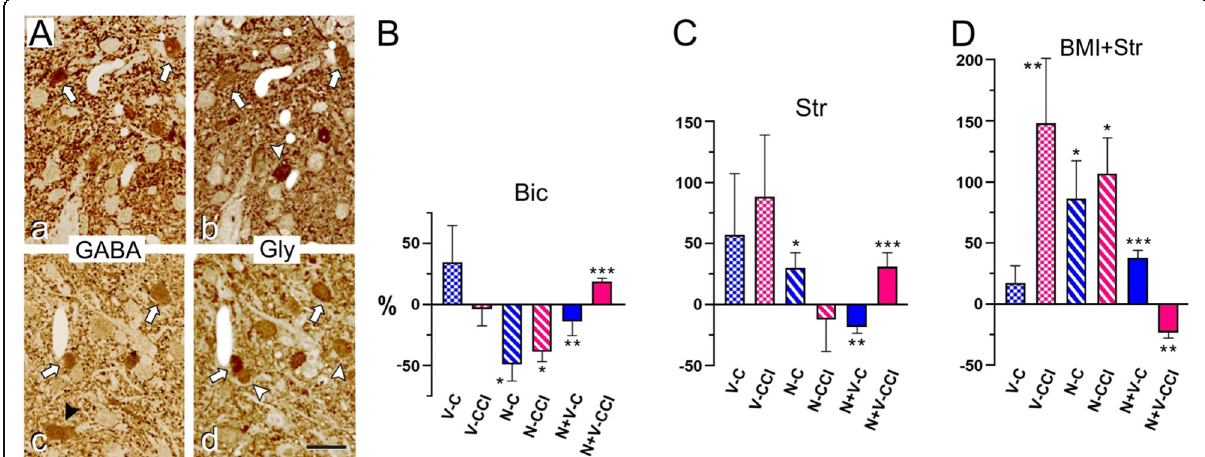
display immunoreactivity for either GABA or Glycine. The majority shows various degrees of coexpression (some are indicated by white arrows), followed by those expressing only Glycine (white arrowheads). A small number of cells are only GABA-immunolabeled (black arrowhead in c ). Scale bar = 20 μ m. ( B - D ) Effect of antagonists of GABA- and Glycinergic neurotransmission on TCC neuronal responses. ( B ) In presence of the GABA A receptor antagonist bicuculline (Bic; 20 mM), GON responses were reduced both in controls and CCI-IoN cases, whereas vibrissal responses were essentially unaltered. ( C ) By contrast, the Glycinergic receptor antagonist strychnine (Str; 100 μ M) increased, albeit non-significantly,